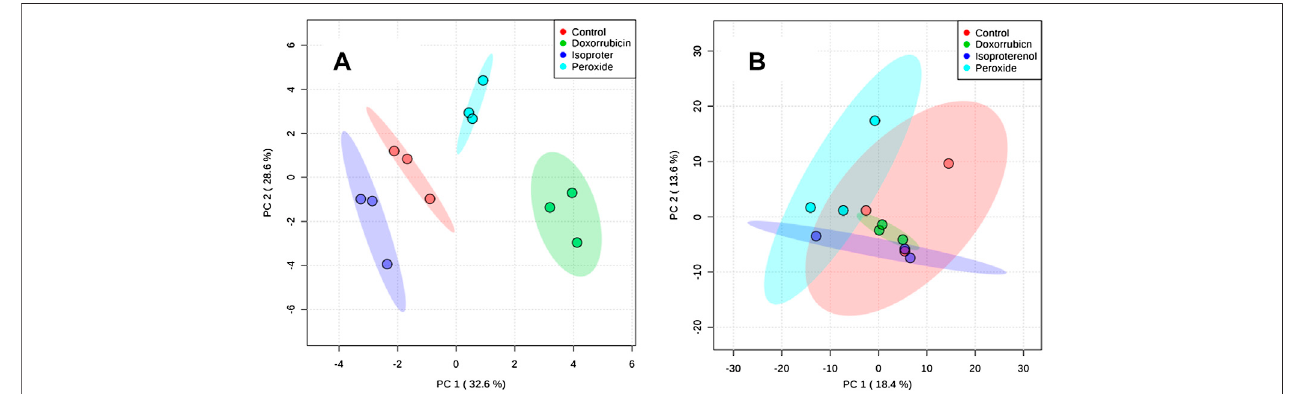
FIGURE 3 | PCA plots generated using all samples. (A) Extract obtained from cells and (B) Supernatant obtained from cell culture medium.